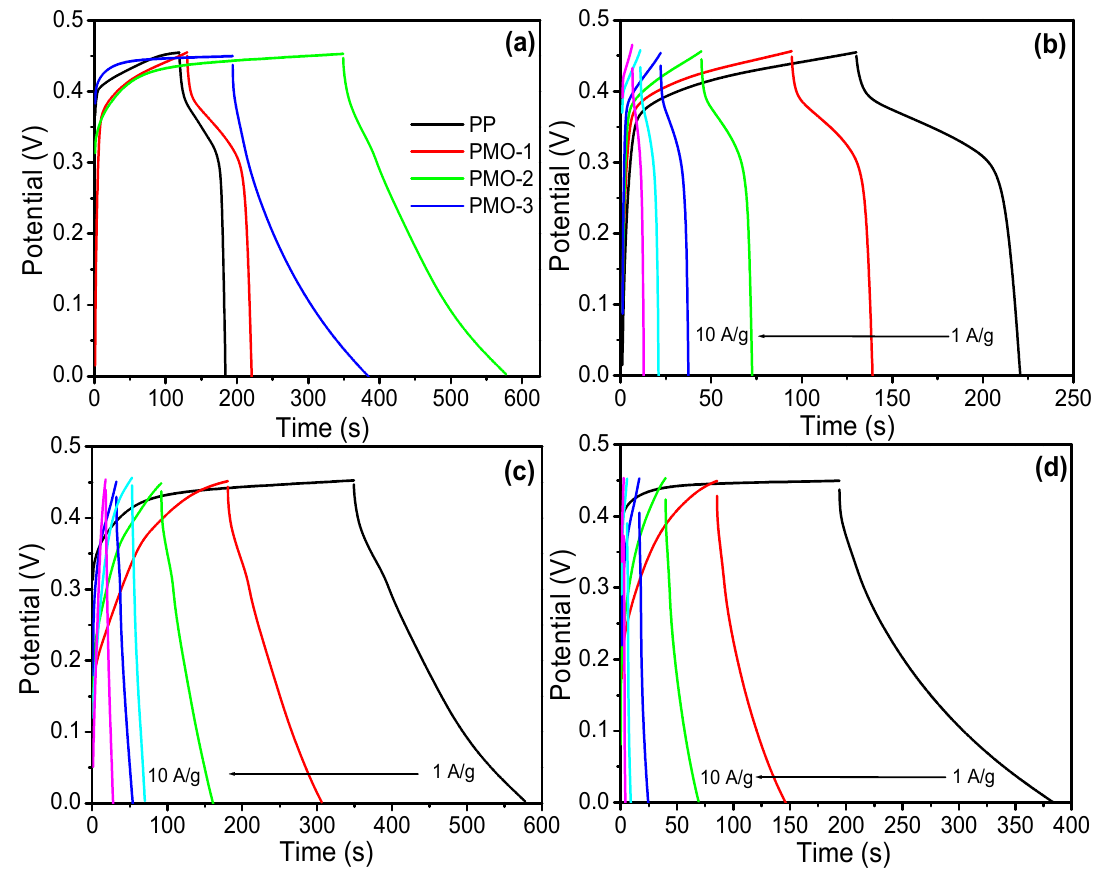
Figure 5. ( a ) Comparative GCD graph of PP, PMO-1, PMO-2, and PMO-3 at a fixed current load, ( b ) GCD graph of PMO-1 at different current densities, ( c ) GCD graph of the PMO-2 at different current densities, and ( d ) GCD graph of the PMO-3 at different current densities.